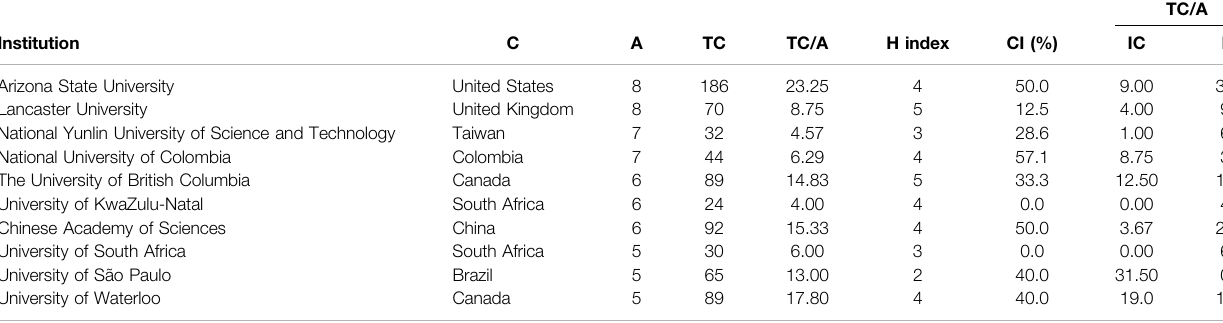
TABLE 4 | Ranking of the ten most productive institutions in sustainable crafts. Source: Authors ’ own. Institution